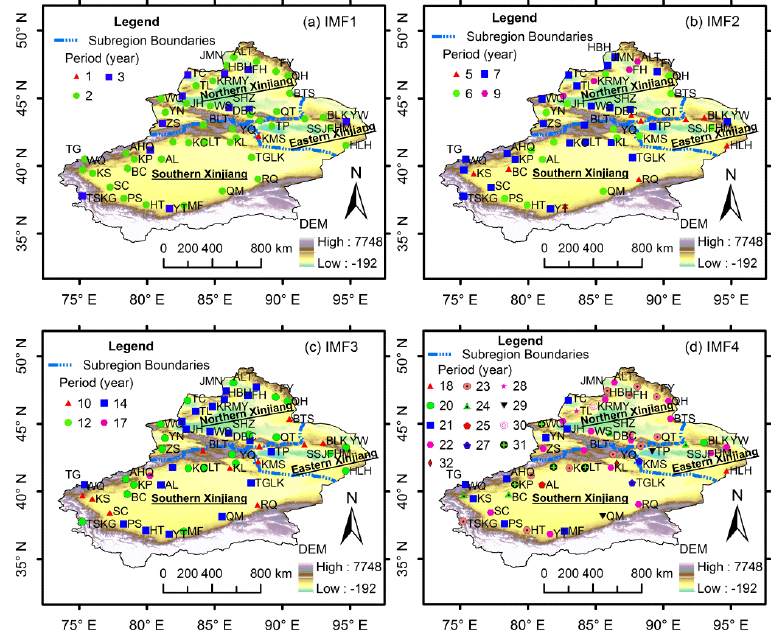
Figure 7. Spatial distribution of quasi-periodic fluctuations of ( a ) IMF1; ( b ) IMF2; ( c ) IMF3 and ( d ) IMF4 in Xinjiang.